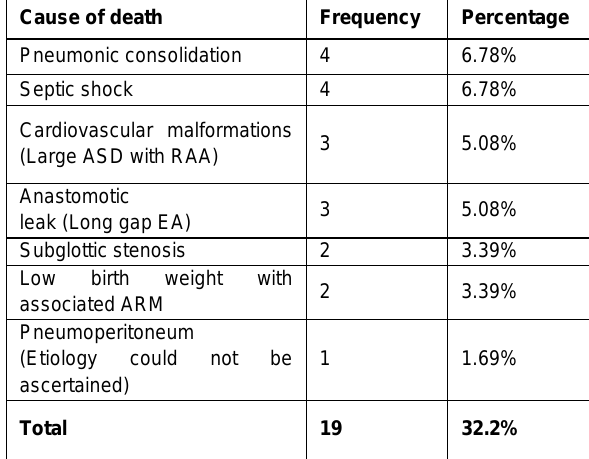
Table 2: Causes of mortality in the patients in our